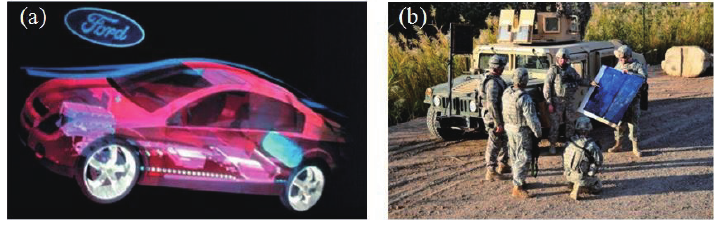
Figure 9. Holographic advertisement ( a ) and holographic map ( b ) produced by Zebra Imaging